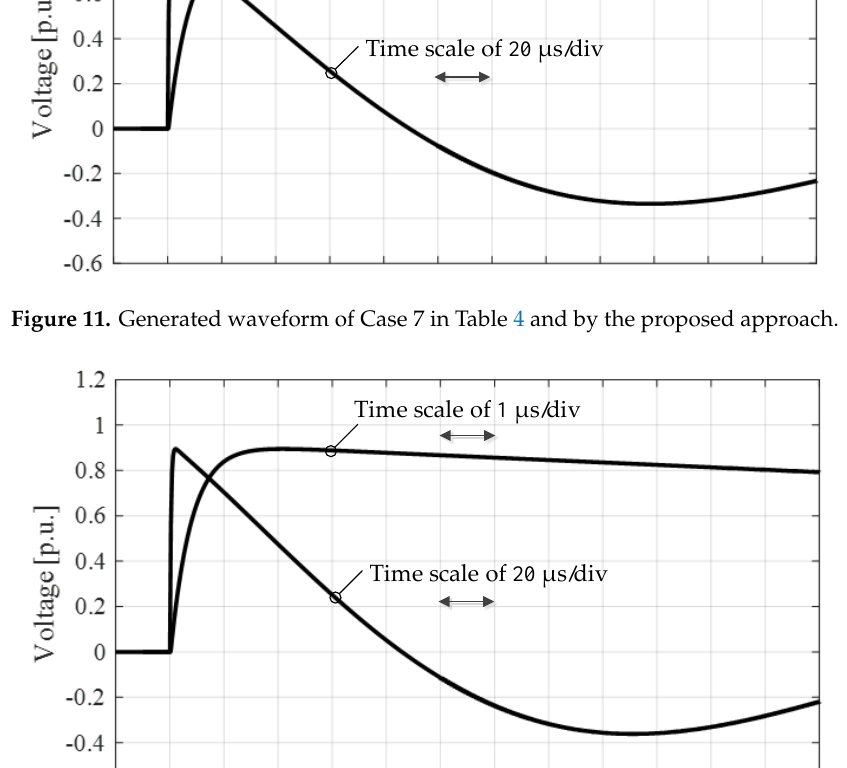
Table 8. Circuit component parameters of the generated waveforms in the example cases. Case